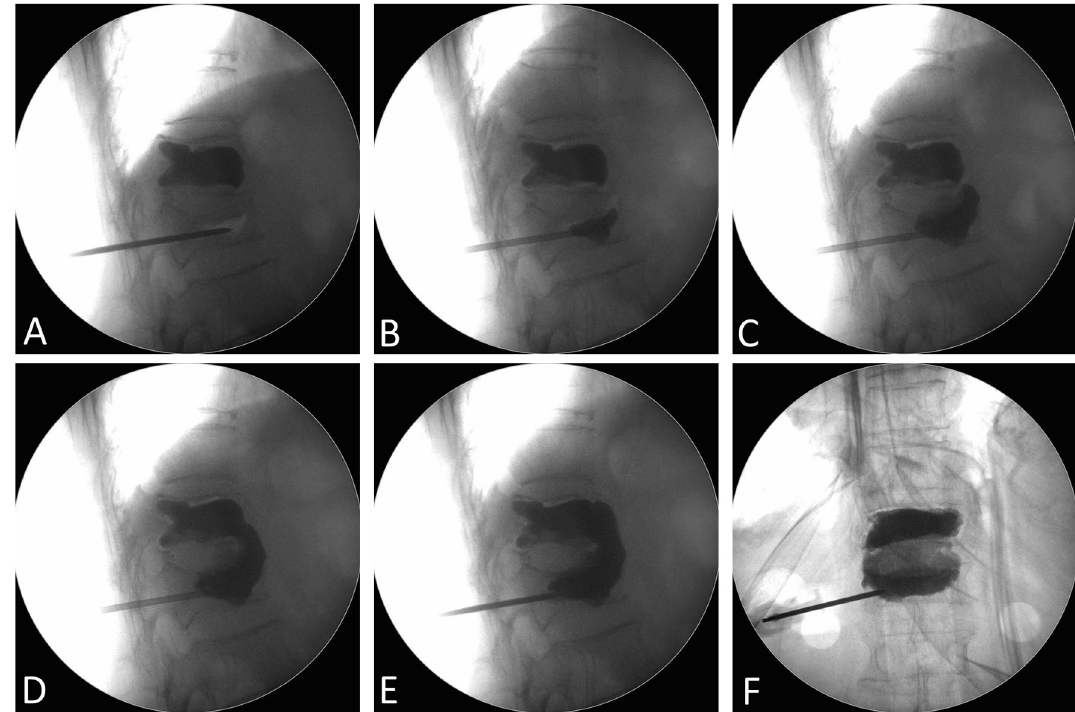
column and then reached the previously cement-augmented